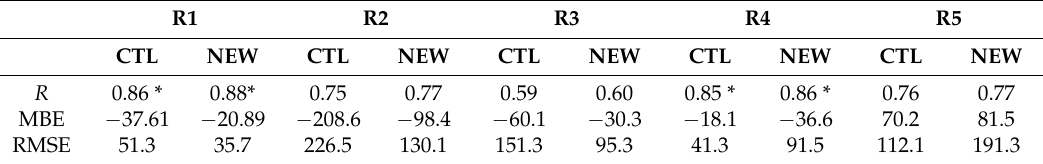
Table 1. Statistical characteristics of annual ET for five typical regions compared to MTE data. (Values with asterisks represent R with significance at the 95% confidence level ( p < 0.05). Units for mean biases (MBE) and root mean square errors (RMSE) are in mm year − 1 .)